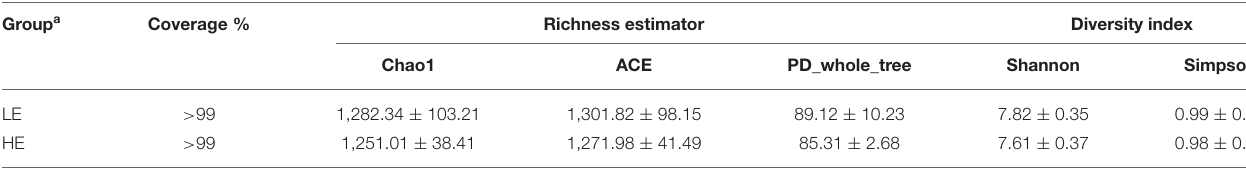
TABLE 3 | Alpha-diversity indices of the rectal microbiota of donkeys. Group